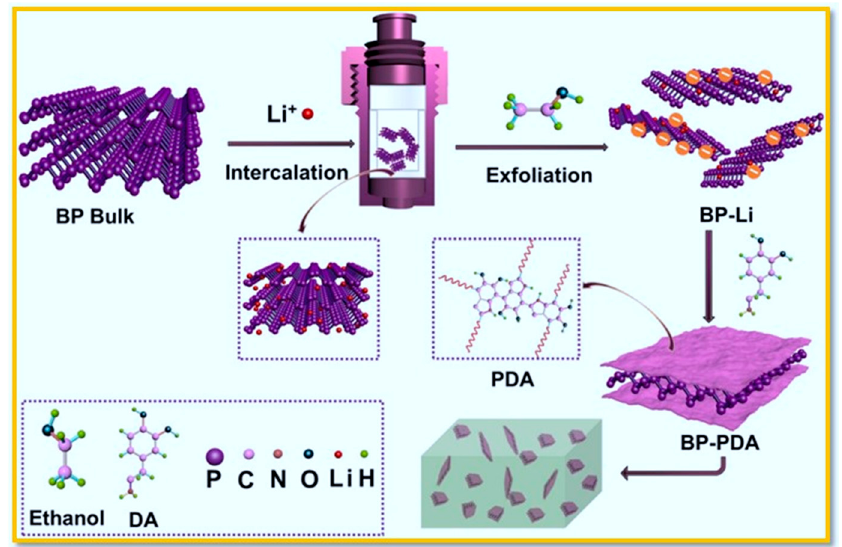
Figure 7. Schematic diagram for synthesis of BP-PDA hybrid and fabrication of PVA/BP-PDA nano-